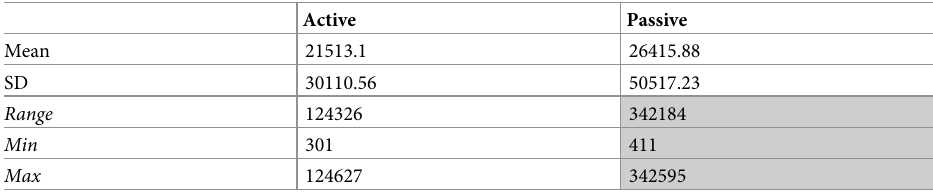
Table 3. Descriptives of verb frequency